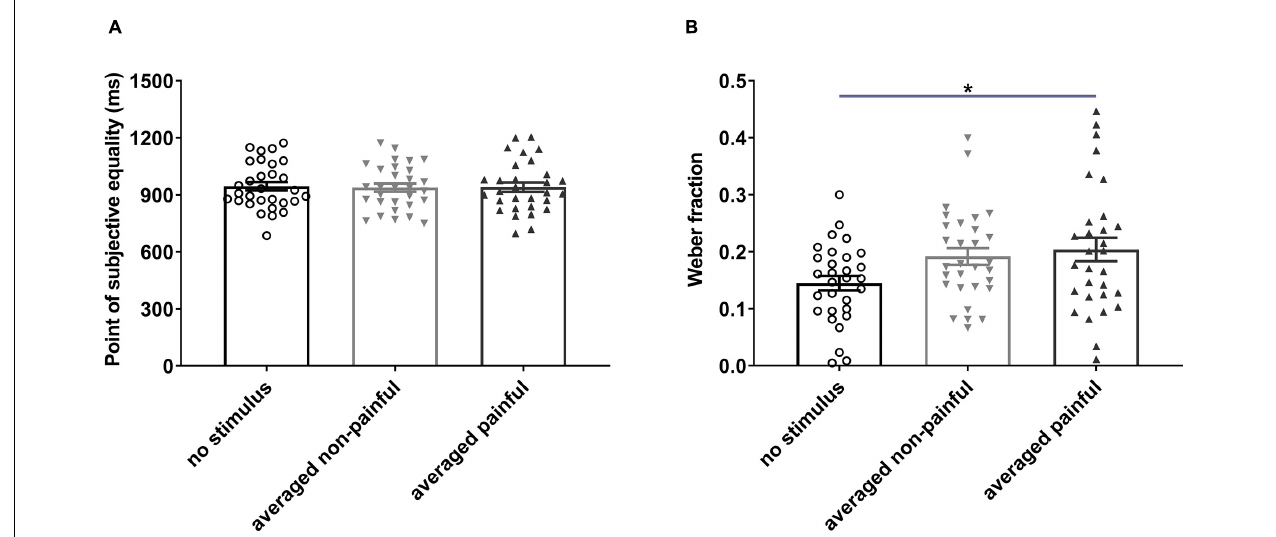
FIGURE 3 | Points of subjective equality (A) and Weber fractions (B) under different electrical stimulation conditions. Averaged non-painful: averaged PSE or WF of 100- and 300-ms non-painful sessions; Averaged painful: averaged PSE or WF of 100- and 300-ms painful sessions. * P < 0.05, averaged painful vs. no stimulus.